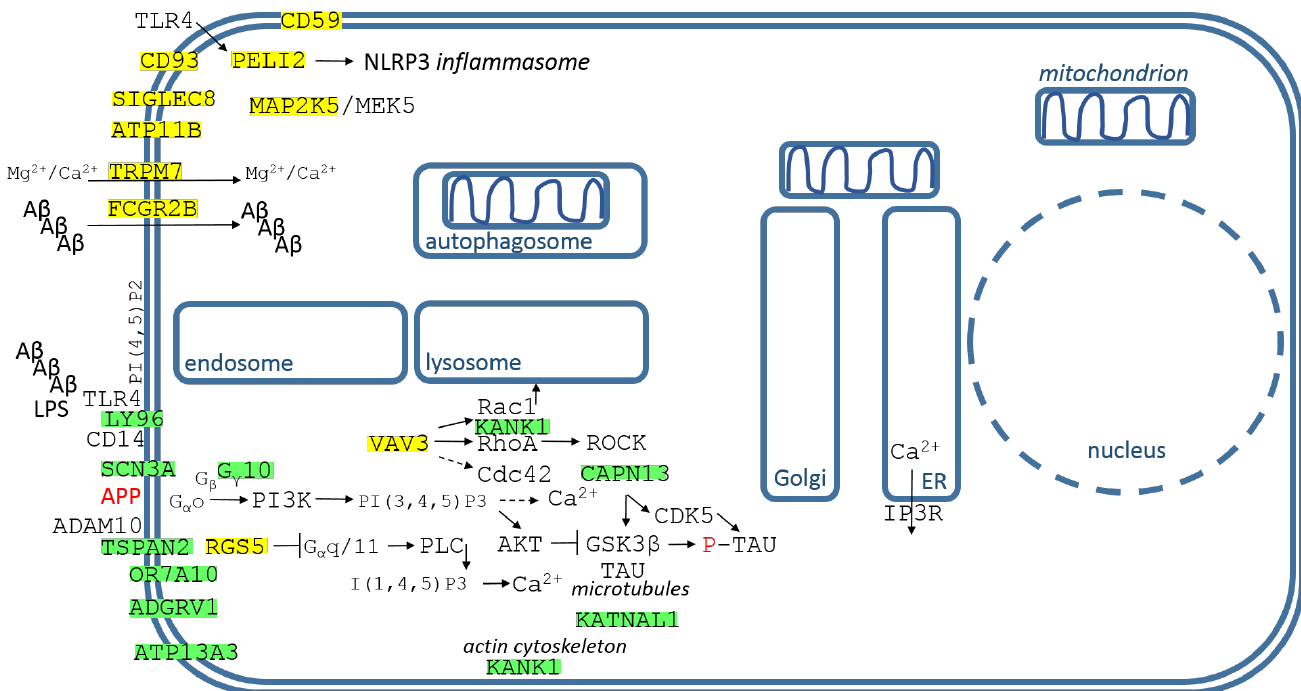
Figure 4. Identified genes/proteins with functions in the plasma membrane and at the PM-cytosol interface. The description of genes/proteins is given in the text from the top left corner down. Green highlights show alignments with the complement sequence (post-transcriptionally repressed), yellow highlights show alignments with the reverse complement sequence (post-transcriptionally promoted).